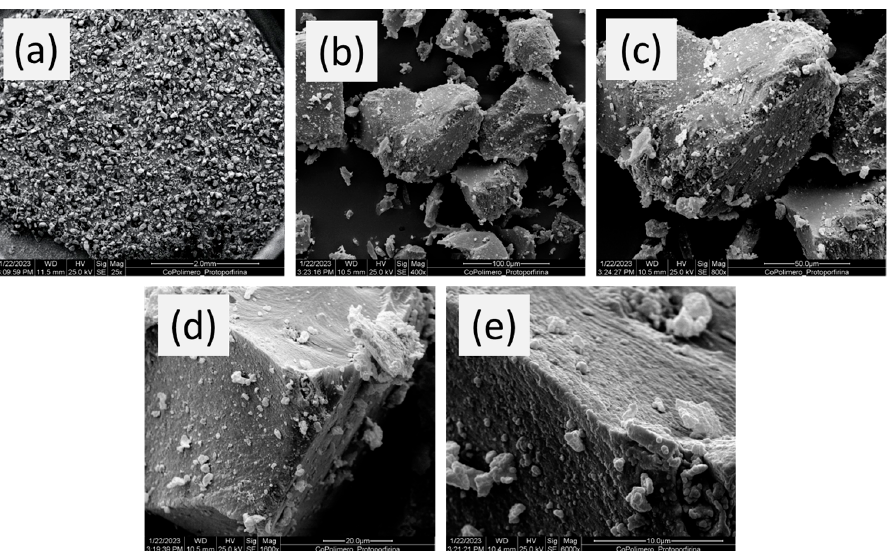
Figure 3. SEM micro-photographs of poly(protoporphyrin -co- vinyl pyridine) at ( a ) 25, ( b ) 400, ( c ) 800, ( d ) 1600, and ( e ) 6000 times magnified with a scale of 2.0 mm, 100.0 µm, 50.0 µm, 20.0 µm, and 10.0 µm, respectively.